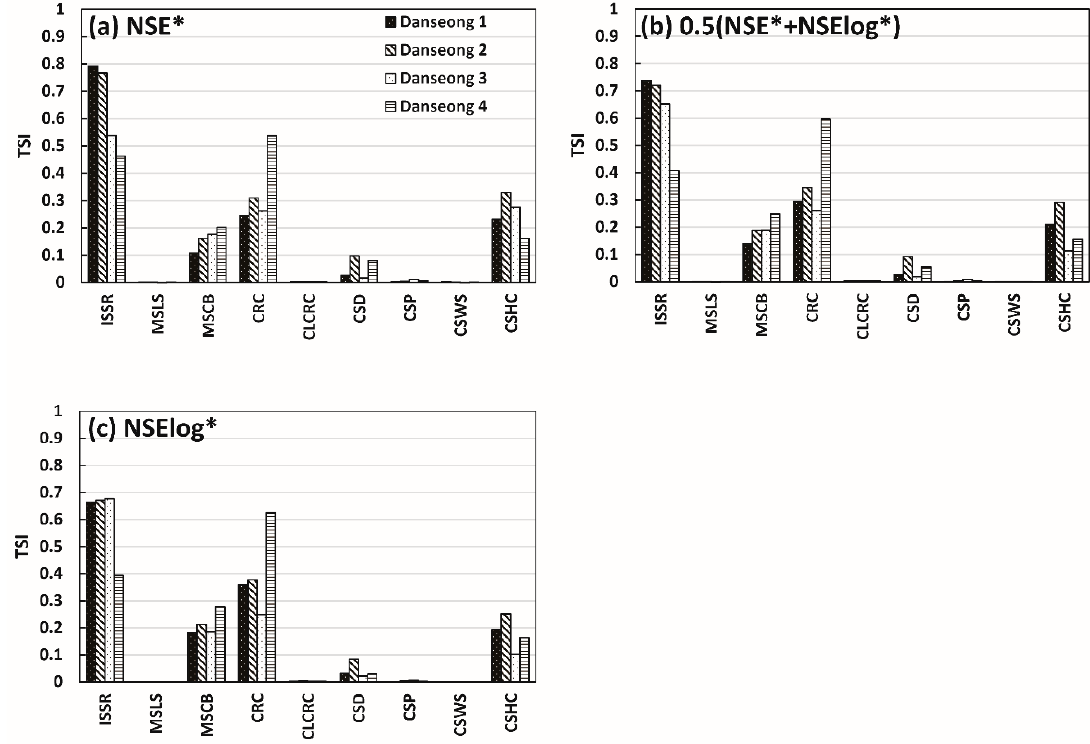
Figure 4. Parameter sensitivity of rainfall events in Danseong catchment, calculated for three objective functions: ( a ) NSE*; ( b ) 0.5(NSE* + NSElog*); ( c ) NSElog*.